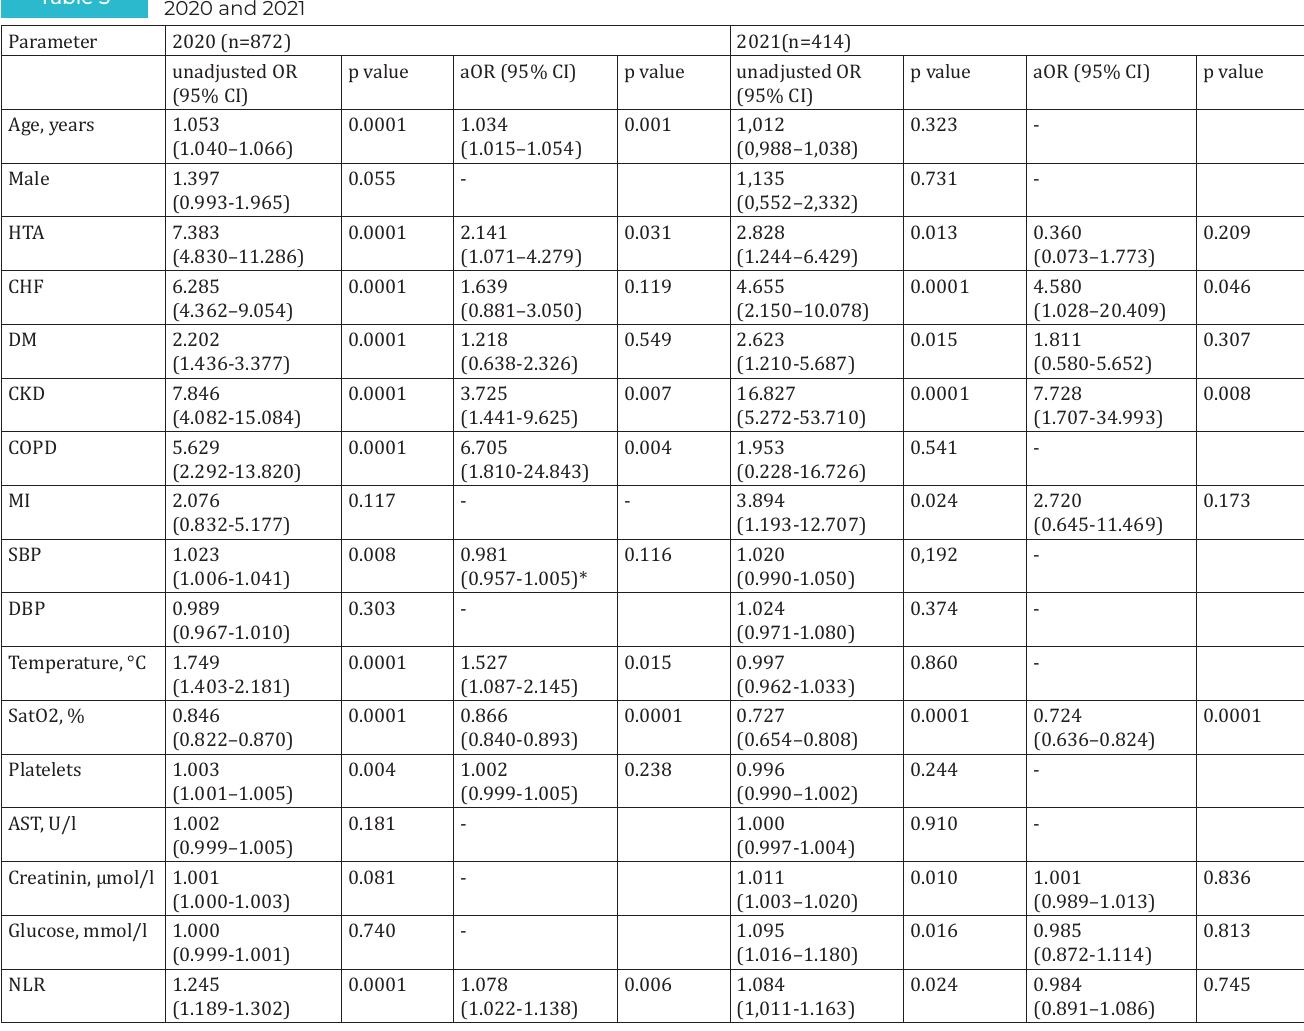
Univariate and multivariate logistic regression analyses of risk variables for association with severe COVID-19 in 2020 and